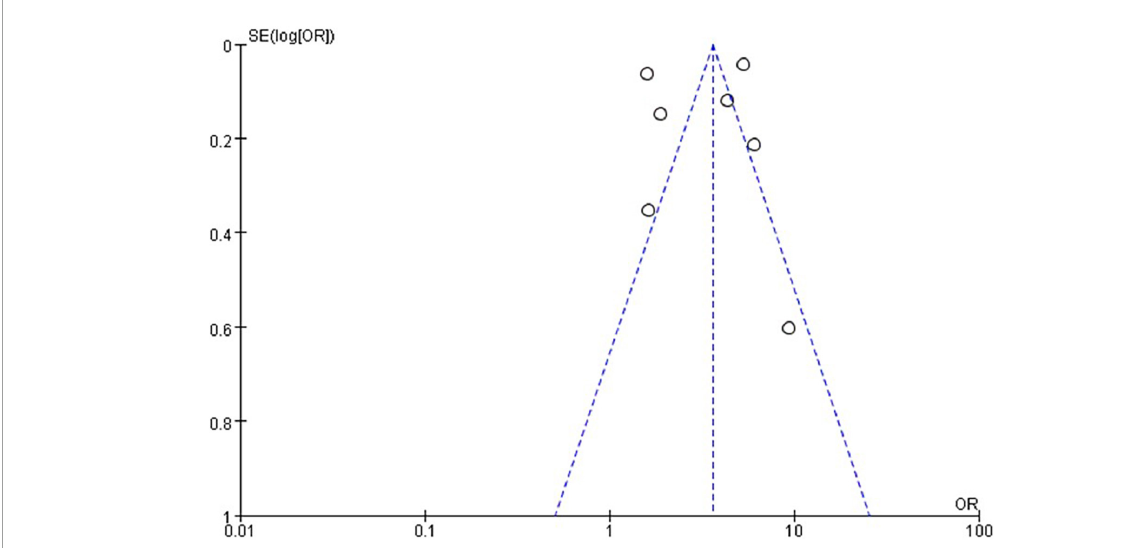
FIGURE2 Funnel plot with grip strength and risk of NAFLD.